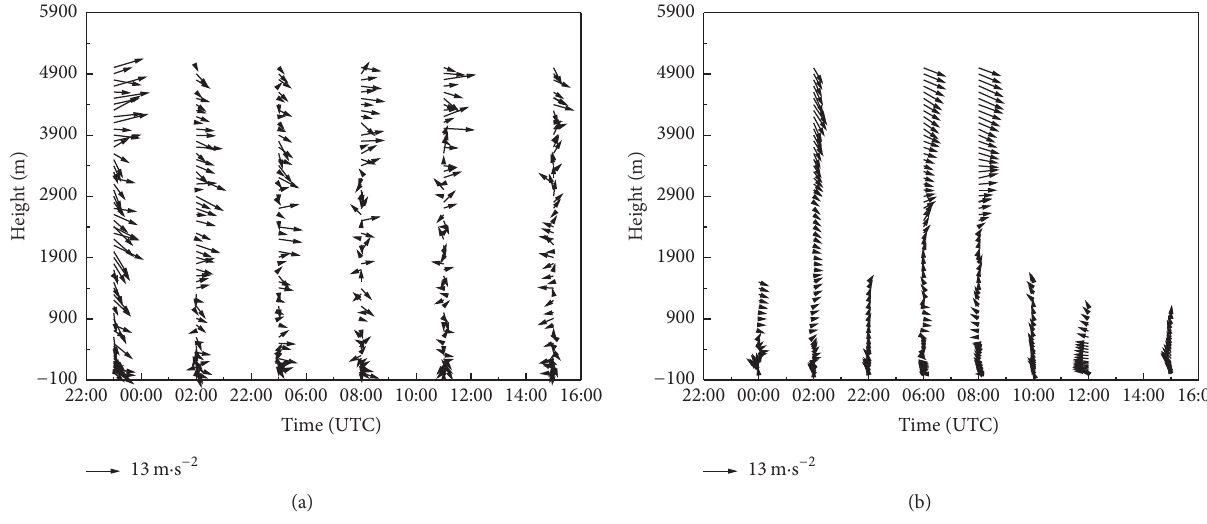
Figure 8: The vertical structure of ABL’s horizontal wind field on (a) July 4, 2012, and (b) August 30, 2009.